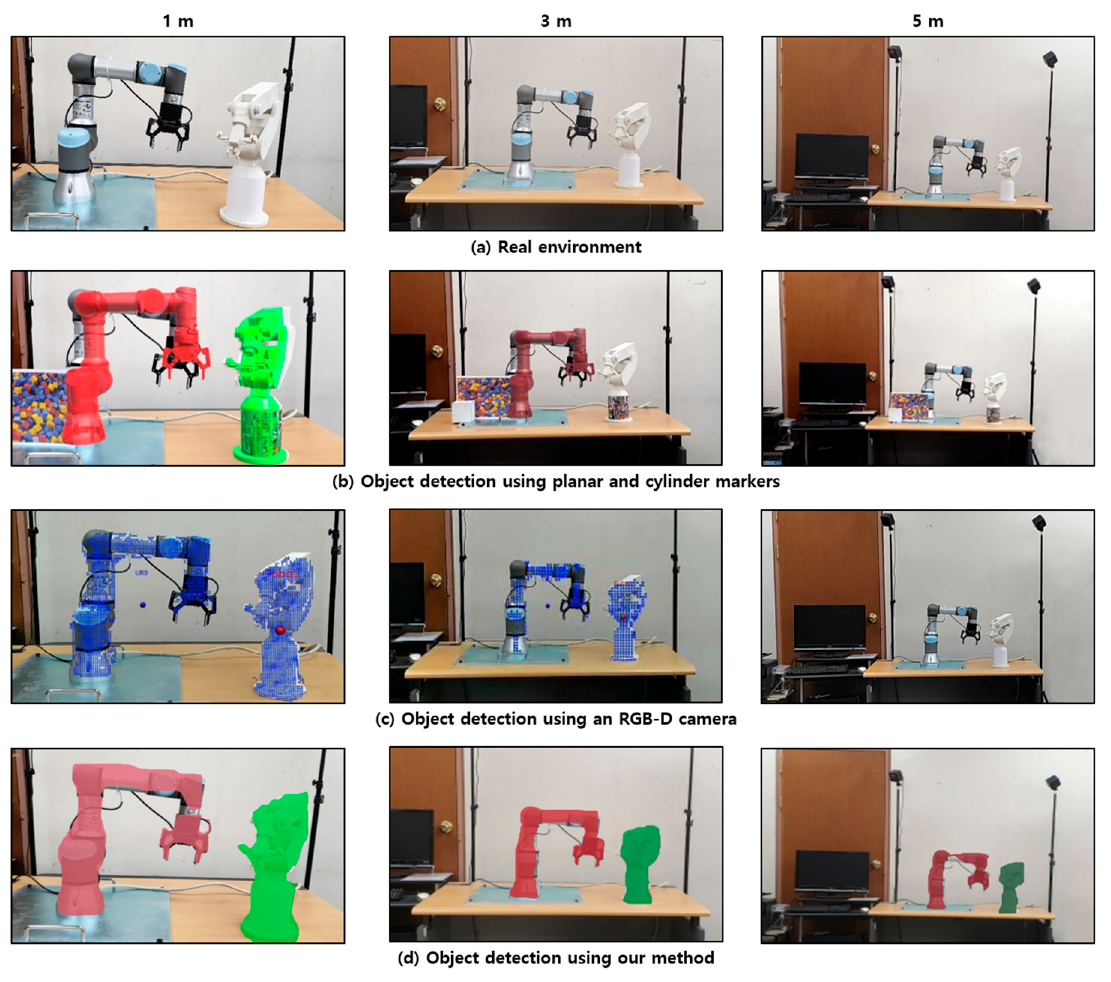
Figure 11. Comparative evaluation of the proposed